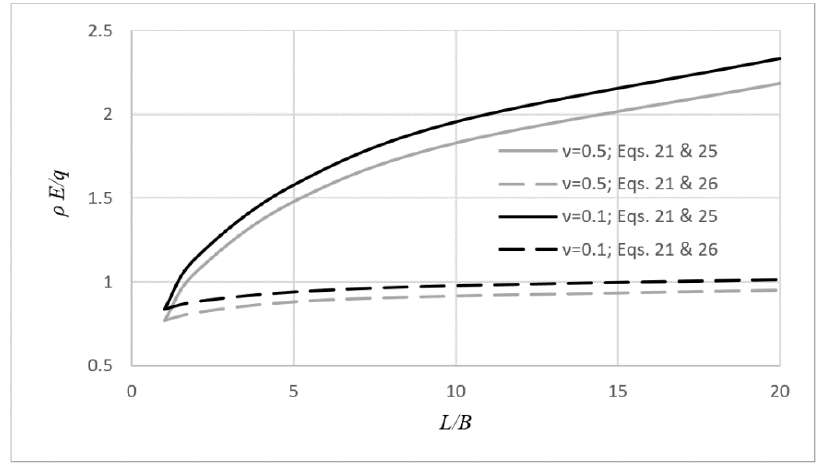
Figure 9. Effect of footing shape on the modulus of soil and, in turn, on ρ E / q .